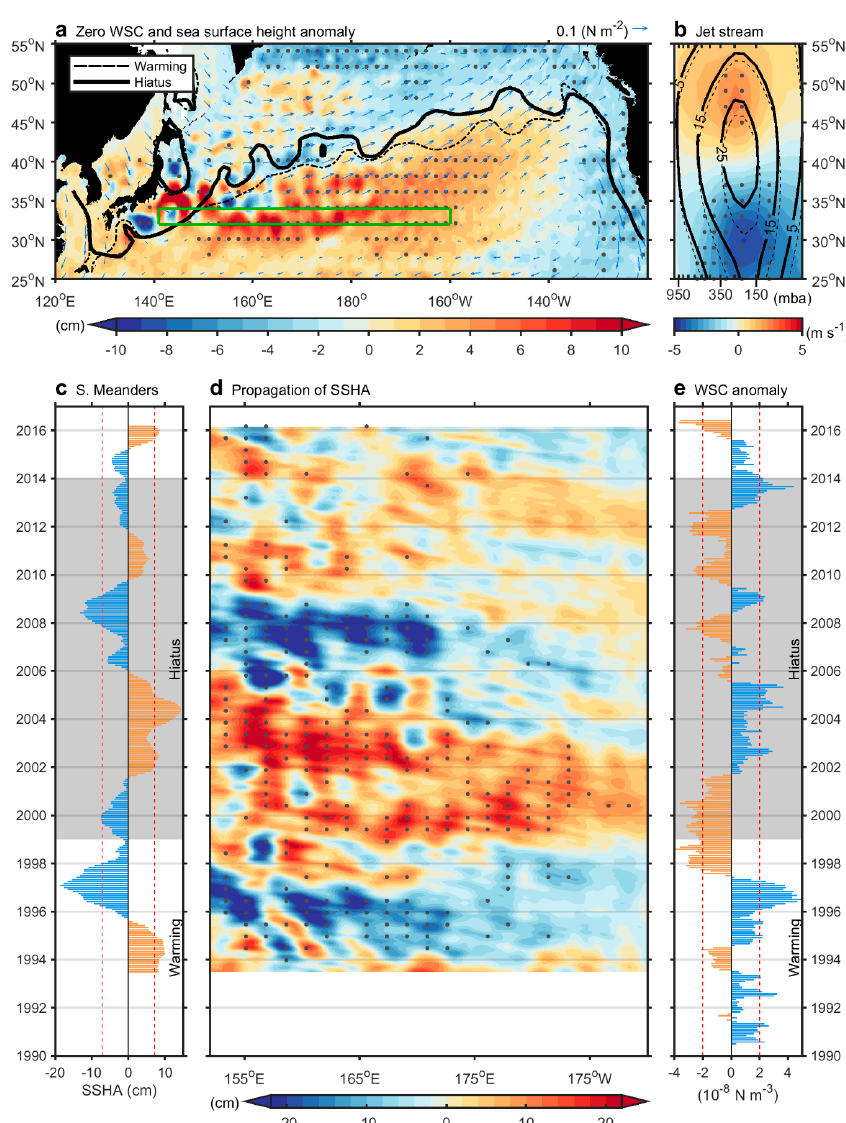
Figure 4. Response of the Kuroshio Extension jet to basin-scale wind change. ( a ) The position of zero wind stress curl during the Pacific warming regime (1993–1998) (black dashed curve) and during the recent hiatus regime (1999–2013) (black solid curve), the mean wind stress (vector), the difference in sea surface height anomaly (SSHA; from AVISO MSLA-DT) (the hiatus regime minus the warming regime), and the domain along the south part of the two quasi-stationary meanders (green box; 141°E–60°W, 32°N–34°N) are shown; ( b ) The zonal average (160°E–140°W) of the vertical zonal wind velocities during the hiatus regime (solid contours) and the warming regime (dashed contours) are shown. The shading indicates the difference in zonal wind velocity (the hiatus regime minus the warming regime); ( c ) The SSHA in the south part of the two quasi-stationary meanders (141–152°E, 32–34°N). The dashed lines indicate one standard deviation interval; ( d ) The SSHA along the latitude of the south part of the two meanders (152°E–170°W, 32°N–34°N); ( e ) The wind stress curl anomaly over the eastern Pacific (170°W–150°W, 30°N–40°N; eastern side of the green box in Figure 4a); ( c – e ) The 13-monthly running average has been applied; ( a – e ) The annual cycle has been removed via the monthly value minus the monthly climatology; ( c , e ) The white and gray shadings indicate the periods of the warming regime before 1998 and the hiatus regime during 1999–2013, respectively; ( a , b , d ) The gray dots indicate statistical significance above the 99% confidence